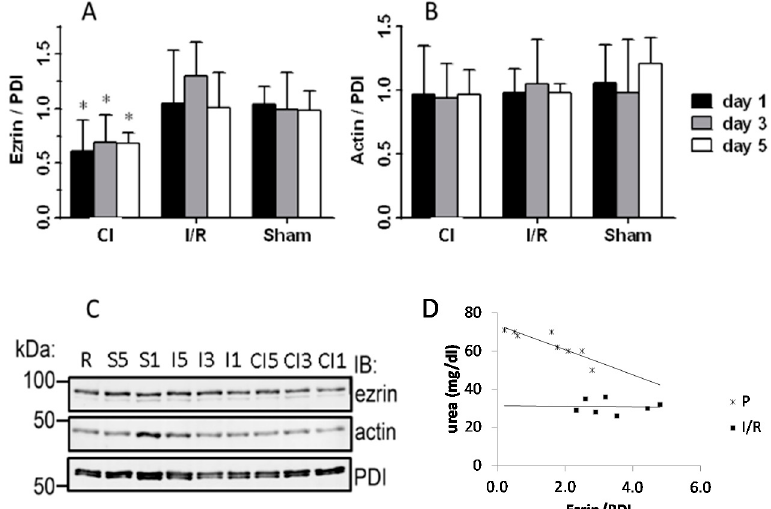
Figure 3. Ezrin and actin expression determined by Western blotting. Western blot image of ezrin, actin and protein disulfide isomerase (PDI) expression. Representative image from nine independent measurements. The samples are: non-ischemic right kidney (R), sham (S5, S1), ischemia-reperfused (I5, I3, I1) kidneys and cold-saline flushed ischemic kidneys (CI5, CI3, CI1). Quantification of Western blots ( B , C ) 1, 3 and 5 days after the operation. The average control value measured in the right kidneys was set to 1. Different blots were compared after normalization to a sample included in all 9 blots (n = 8 in all groups). ( A ) Quantification of ezrin presented as ezrin/PDI ratio. *: p < 0.05 vs. corresponding sham. ( B ) Quantification of actin presented as actin/PDI ratio. Actin expression was not influenced significantly. ( C ) Representative Western blots of ezrin, actin and PDI at various days after the interventions. ( D ) Correlation of ezrin content with blood urea level. The data shown were obtained 1 day after the operation in rats with cold-saline flushed ischemic kidneys (y = 6.539x + 73.741, R2 = 0.7644, p < 0.01) or in ischemia-reperfused kidneys (y = − 0.1755x + 31.453, R2 = 0.00196, NS = not significant); the slopes are significantly different ( p < 0.01).